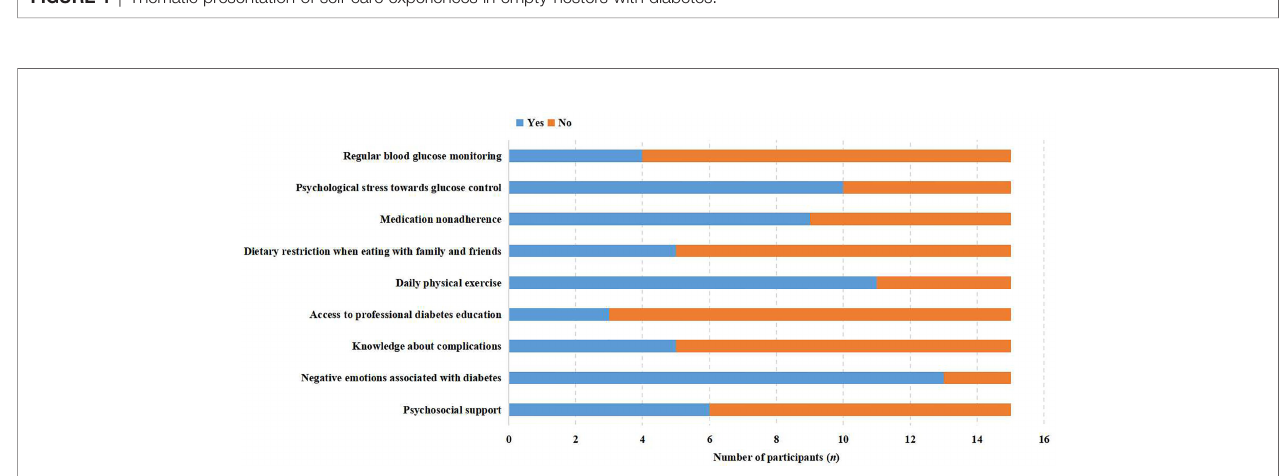
FIGURE 2 | Participant responses to each question.